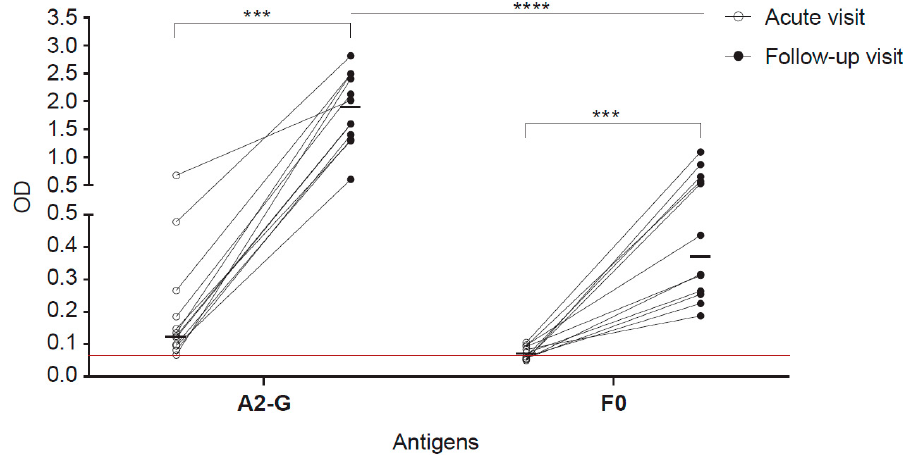
Figure 8. IgG responses specific for G and F0 in children with an acute wheezing attack at base-line and in follow-up blood samples. Shown are optical densities (ODs) corresponding to IgG levels specific for A2-G and F0 determined in sera from children attending emergency care at base line (open circles) and in follow-up samples collected several weeks after (black circles). The cut-off (mean of buffer control plus three times standard deviation) is indicated by horizontal red lines. Horizontal lines within the scatter plots indicate median values. Depicted are 12 RSV-positive children according to PCR test. Comparative tests were non-parametric paired (Wilcoxon matched-pairs signed rank test) or unpaired test (Mann-Whitney U test) as appropriate. Significant differences of antibody levels between base-line (acute visit) and follow-up samples are indicated (*** p < 0.001, **** p < 0.0001).